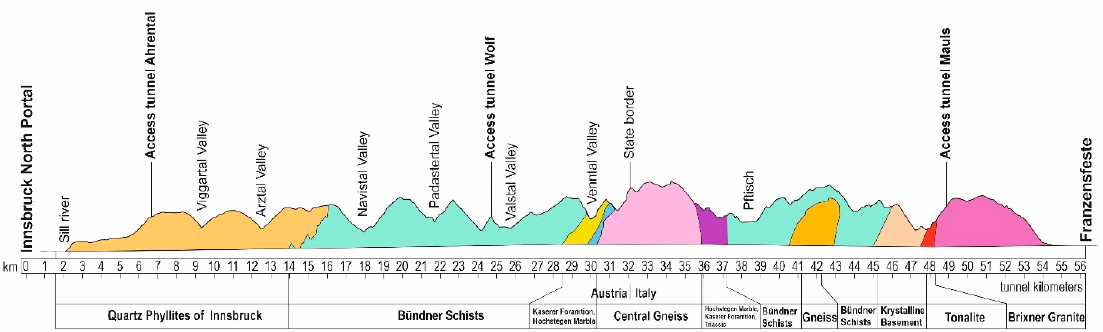
Figure 3. Simplified geological cross section through the Brenner Base tunnel according to [29].